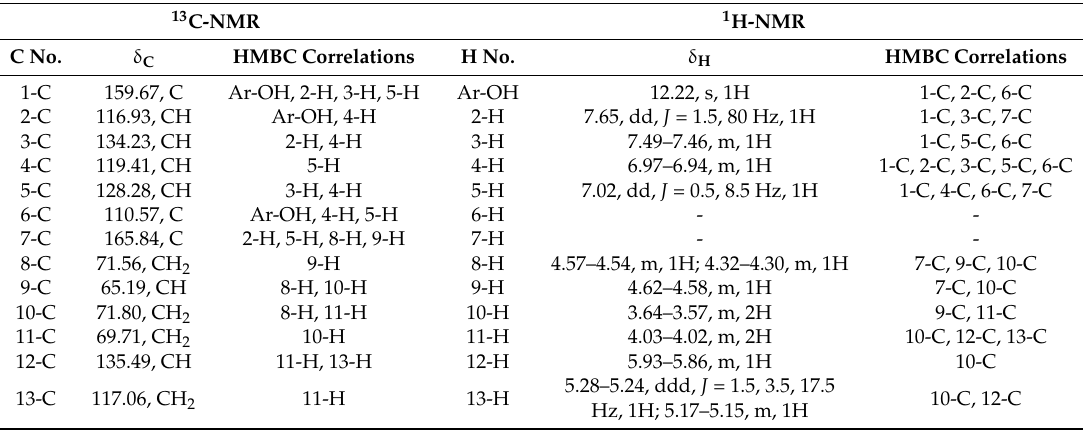
Figure 3. The main HMBC of compound 6f . Table 4. HMBC data of compound 6f